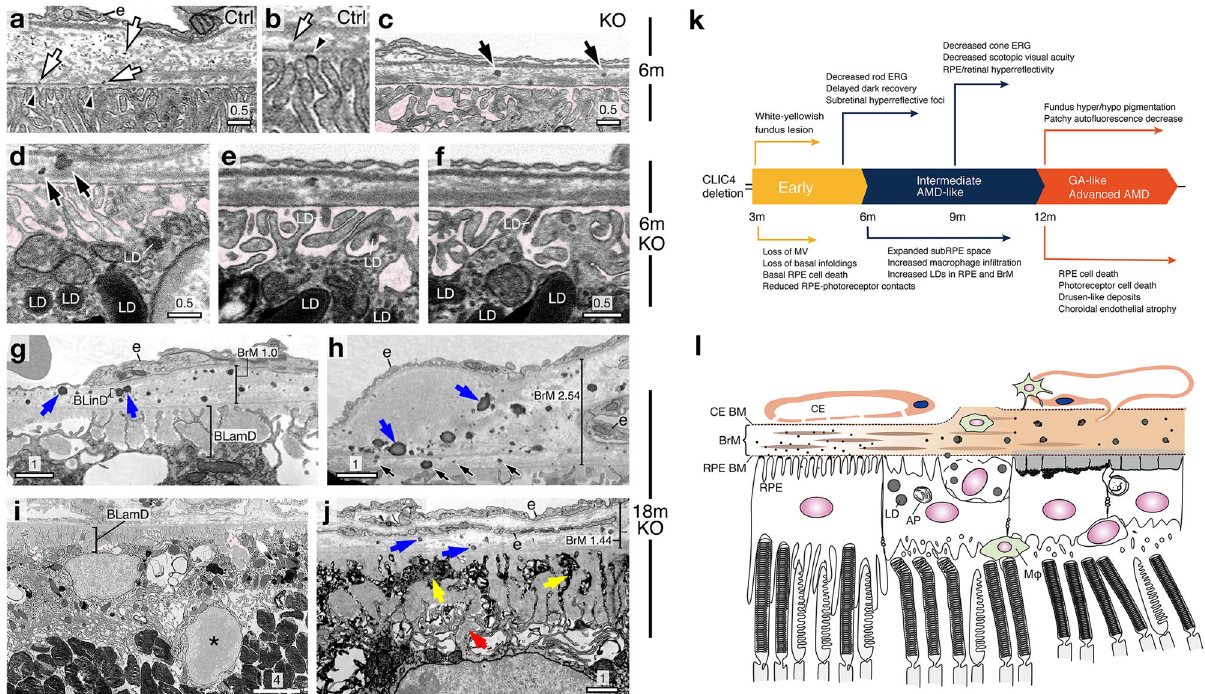
Fig. 6 RPE lipid transport, BrM lipid deposition & disease summary for RPE Δ Clic4 mice. a , b FIB-SEM images of 6-month-old Ctrl mouse RPE-BrM-choroid complex reveal lipoprotein-like particles diffusely expressed in the BrMs (arrows) and emerging from the dark lipid-rafts of the basal plasma membranes (arrowheads). Also see Video 1. e Choriocapillaris. c – f FIB-SEM images of 6-month-old KO mice show the BrM expression of spherical-shape LD-like structures, which are decorated with multiple lipoprotein-like granules (arrows in c , d ). The BrM-expressed LDs shared similar pro fi les to those detected in the basal RPE cells ( d ) and sub-RPE space ( e , f , highlighted in pink). Also, see Videos 2 and 3. g – j Representative TEM images of 18-month-old KO mice reveal the BrM-expressed LDs coated with dark particles (blue arrows) and variable size of the lipoprotein-like aggregates. These lipids were frequently seen at the BrM-RPE junction (black arrows in h ), but not at the BrM-choroid junction. BrMs display dome-shape large deposits (in h ) and endothelial cells ( e in h , j ). Labeling indicates the thickness of BrM (in μ m), a migratory RPE cell (asterisk in i ), the membranous debris associated with multi-lobed shape BLamD (yellow arrows in j ) and long-spaced collagen (red arrows in j ). Scale bars are in μ m. a – j Representative images of three independent experiments. k The temporal order of the AMD-like clinicopathology (top) and histopathology (bottom) manifested in RPE Δ Clic4 mice. l A cartoon depicts the retinal- RPE-BrM-choroid complex of a Ctrl mouse (left) and the progressively developed lesions in the RPE Δ Clic4 mice (middle to right). CE choriocapillaris. AP autophagosomes. M φ macrophages (green). BM basement